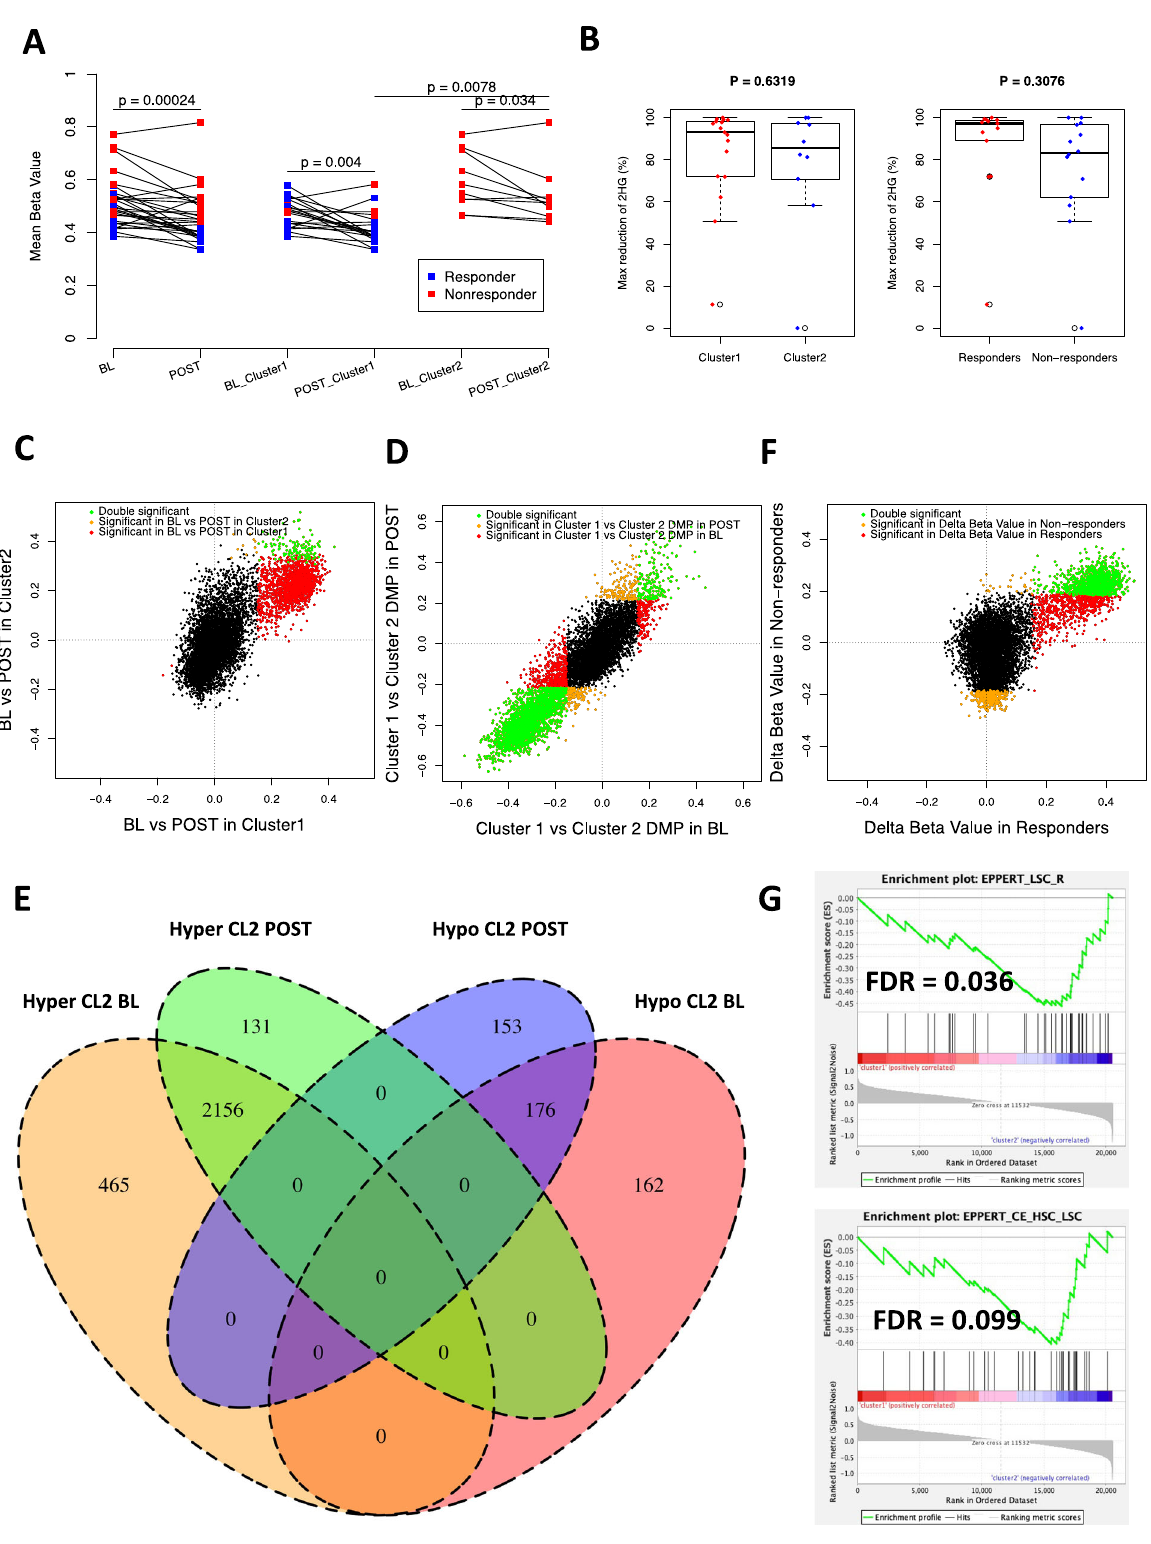
association with the absence of co-occurring DNMT3A muta- tions. While we found correlation between hypermethylated DMPs and downregulation of genes associated with hemato- poietic differentiation, whether the hypermethylated phenotype (or the lack of co-occurring DNMT3A mutations) is directly